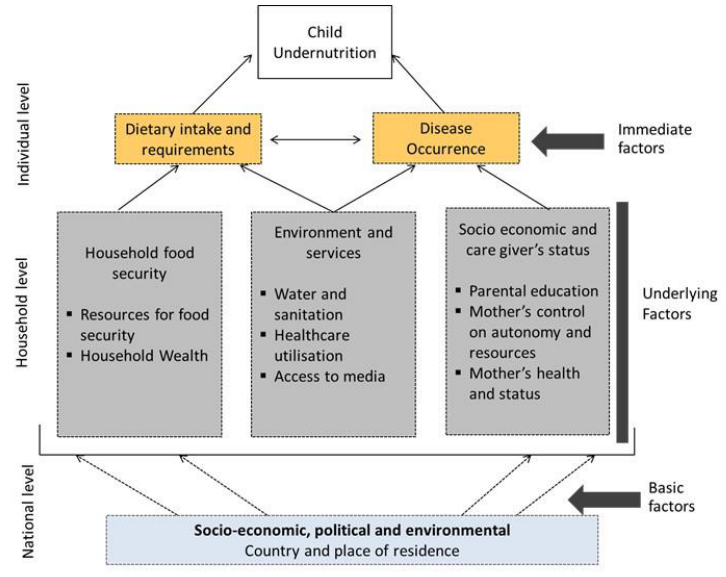
Figure 1. Conceptual framework of the determinants of child undernutrition.